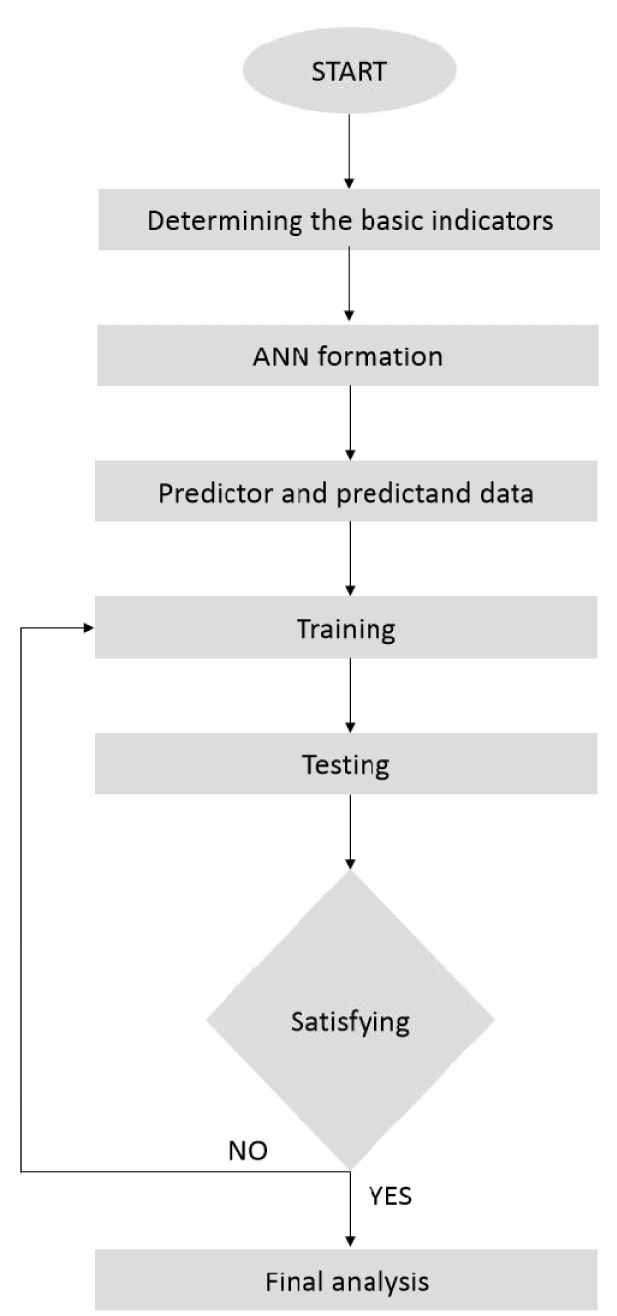
Figure 2. Downscaling algorithm using